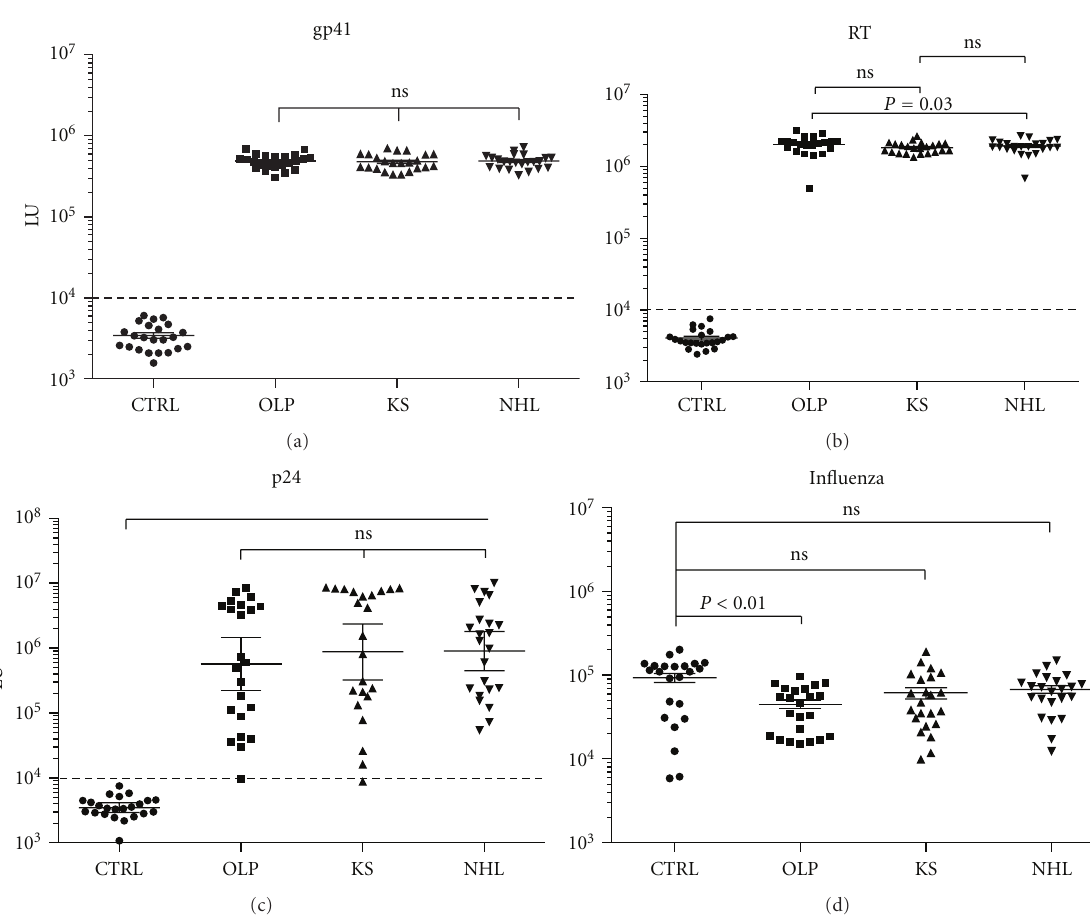
Figure 1: HIV antibody profiling in the uninfected blood donors and HIV patients with OLP, KS, and NHL. The antibody level and 95% CI for (a) gp41 (b) RT, (c) p24, and (d) HA2 influenza antibodies in the 23 control blood donors, 23 OLP, 23 KS, and 23 NHL subjects were scale. Each symbol represents a sample from one individual. The dashed line represents the cut-o ff level plotted on the Y -axis using a log 10 for determining seropositivity and is derived from the mean plus 5 standard deviations of the antibody values of the controls. P values for the di ff erent groups were calculated using the Mann-Whitney U test.